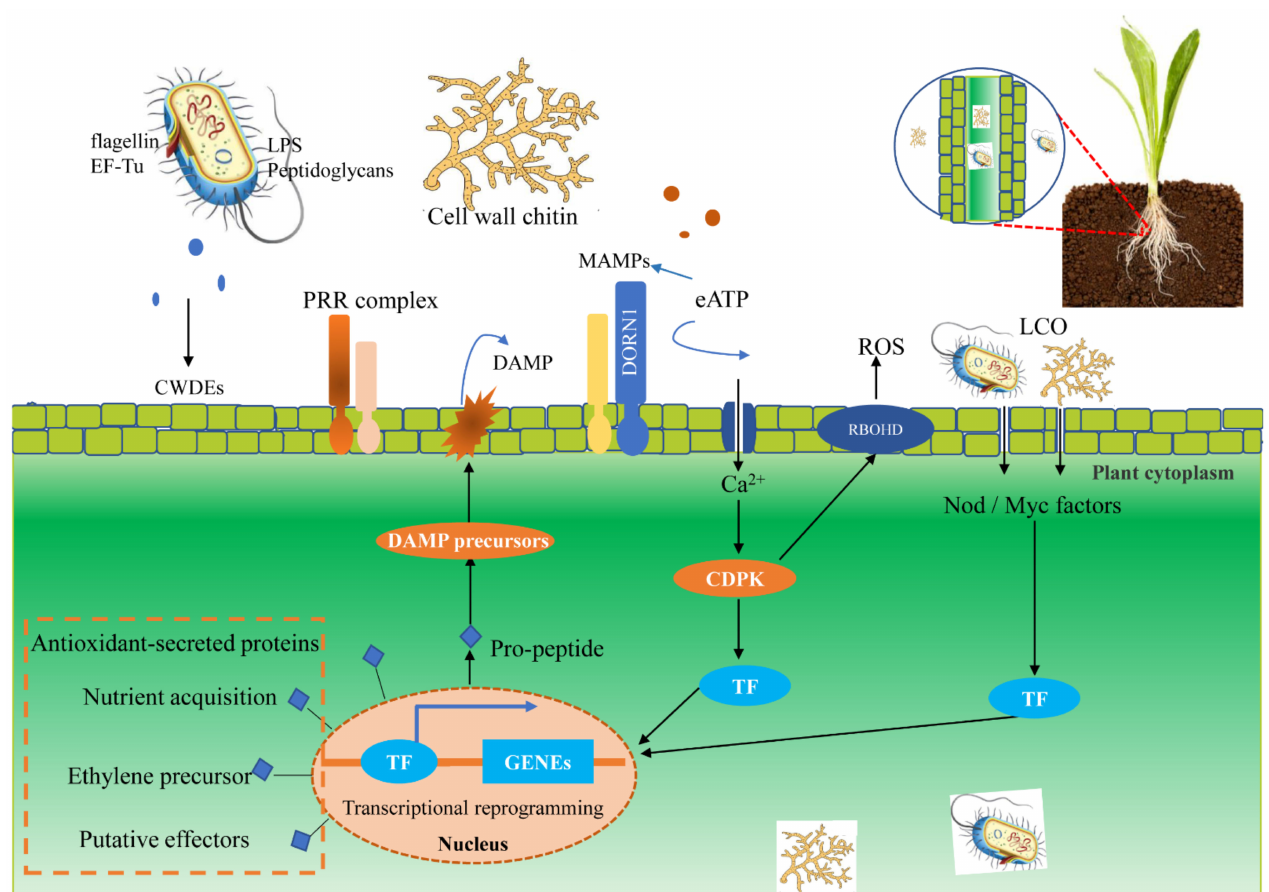
Figure 1. Plant immune recognition of microorganisms and colonization of endophytes in plant cells. Once invaded by microorganisms, the plant can recognize their individual receptors, such as fungal cell wall chitin, and finally make an immune response. On the MAMPs/DAMPs perception of inducing the formation of receptor complexes, PRR activate intracellular signal transduction, which involves Ca 2+ signaling, CDPK, in a wide range of transcriptional reprogram- ming intermediate and defense-related TF. In addition, microbial apoplastic eATP can activate the Ca 2+ signal. The transcriptional expression of plant nuclei can be affected by the colonization of microbe in plant tissues, which may be beneficial for plant survival and endophyte colonization. Abbreviations: microbial/damage-associated molecular patterns (MAMPs/DAMPs), pattern recognition receptors (PRR), Ca 2+ -dependent protein kinase (CDPK), lipo-chitooligosaccharide (LCO), lipopolysaccharides